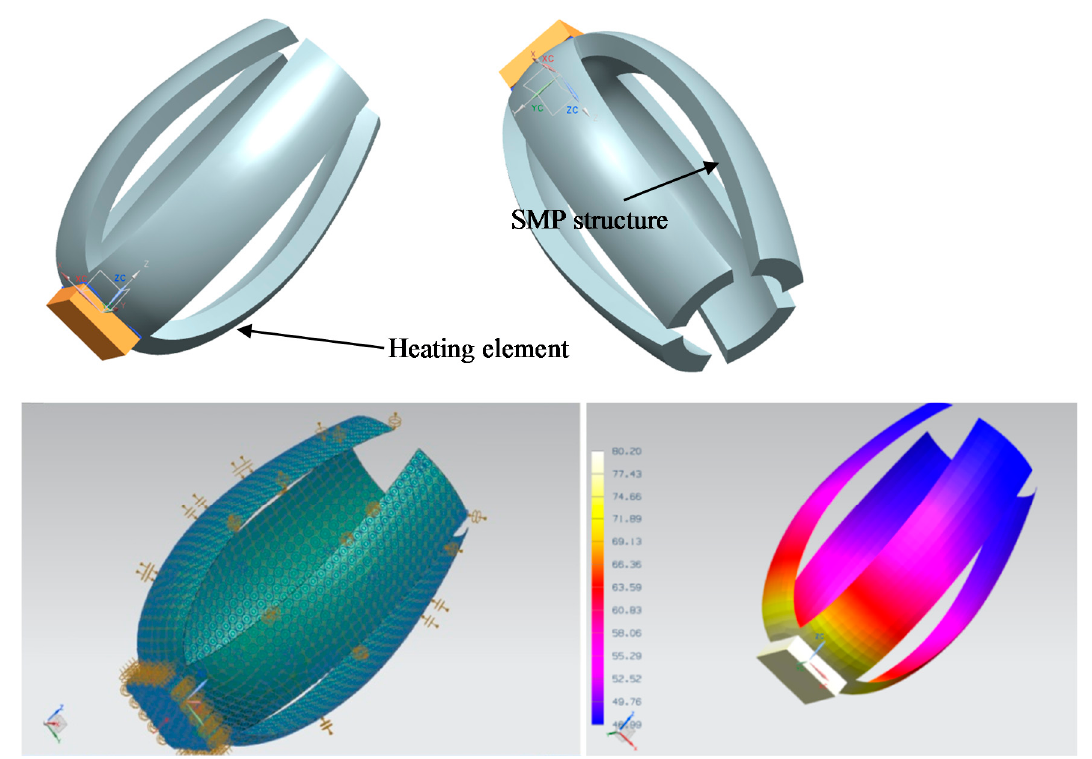
Figure 3. Example of a heating system for SMP activation designed using FEM (finite-element modeling) simulations.